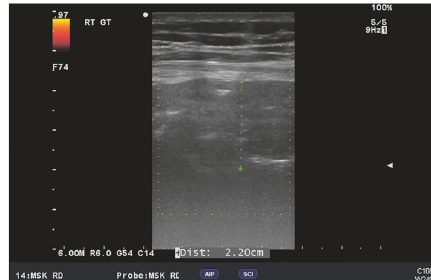
Figure 1: Ultrasound of the right hip showing an inhomogeneous hypoechoic fluid collection with internally scattered echogenic debris between the skin and the right greater trochanter measuring approximately 8 × 3 × 2.5 cm which raised the suspicion of a metal- on-metal ALVAL